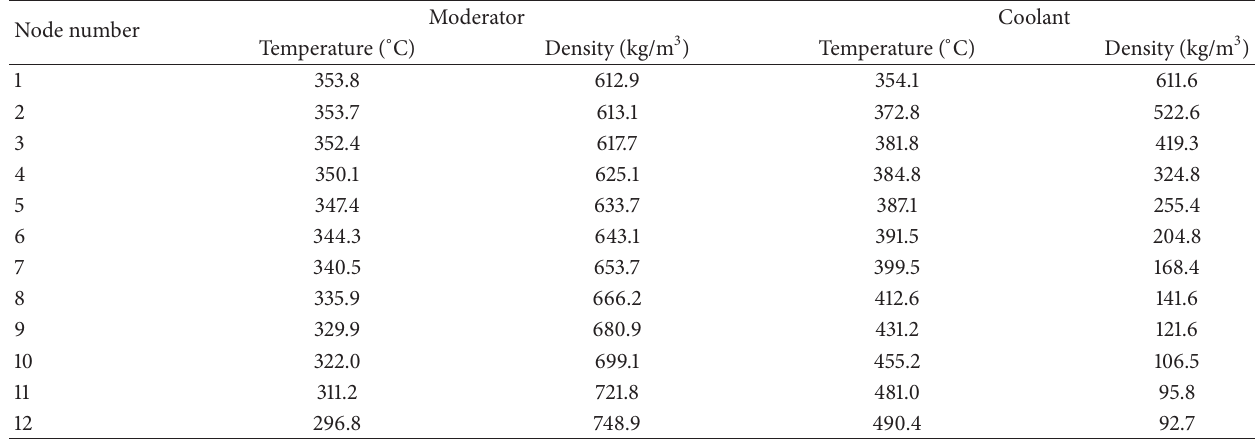
Table 3: Temperatures and densities of moderator and